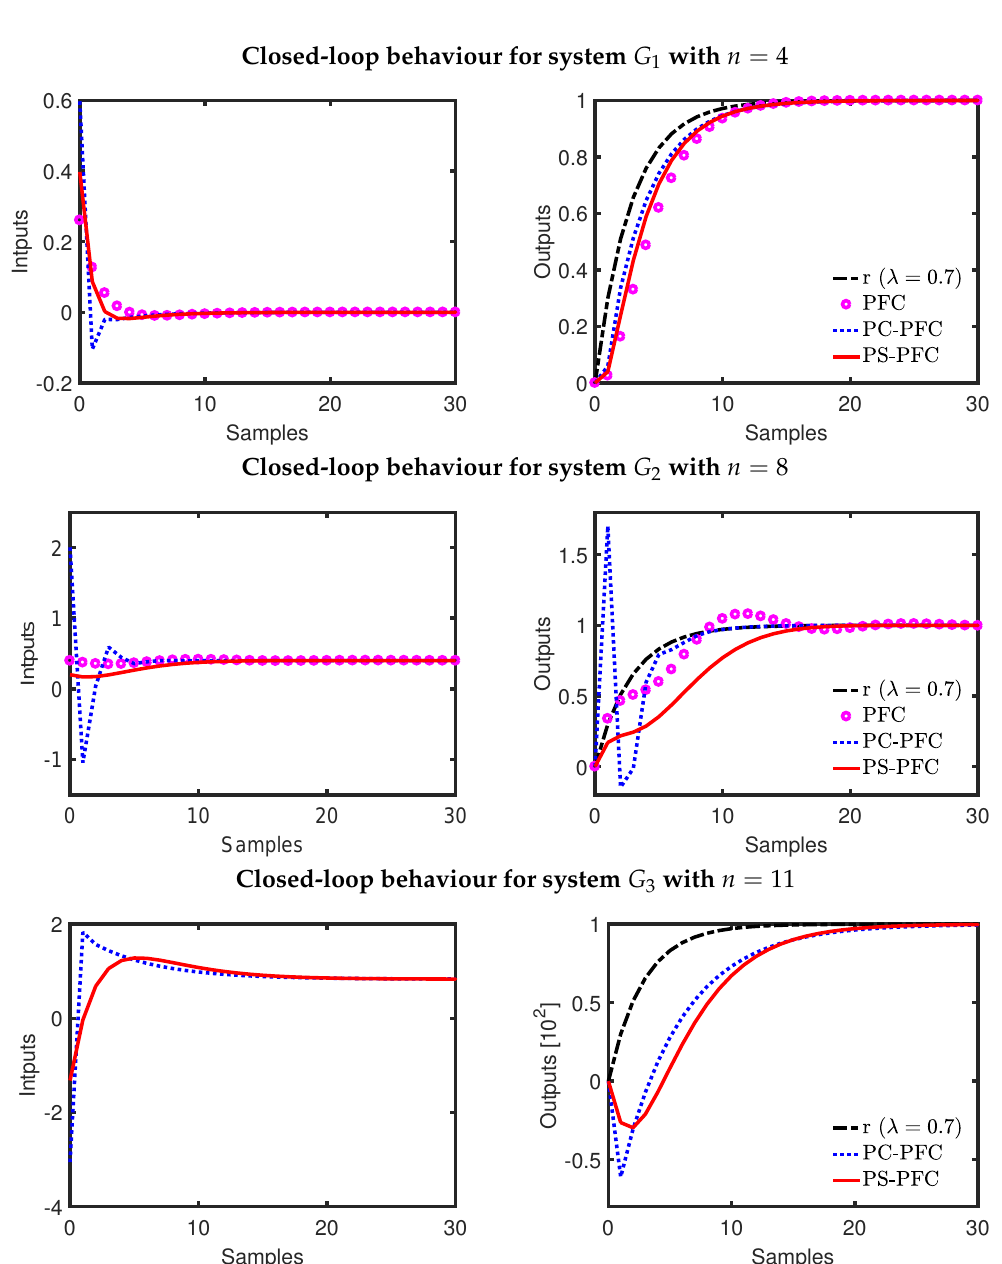
Figure 3. Closed-loop input and output behaviour of PC-PFC and PS-PFC for processes G 1 , G 2 , G 3